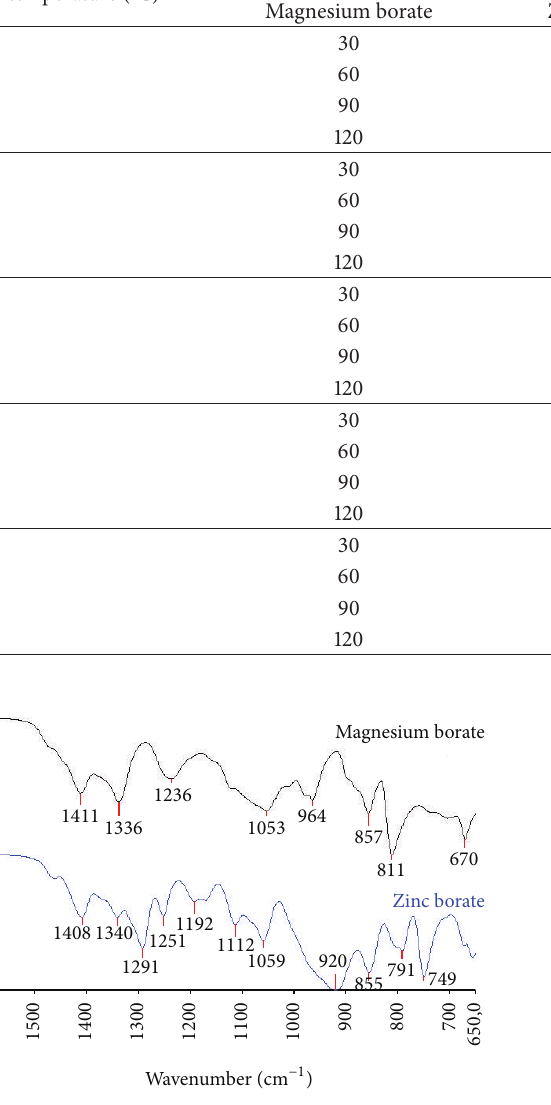
Figure 4: FT-IR patterns of the optimum phases of the magnesium and zinc borates.